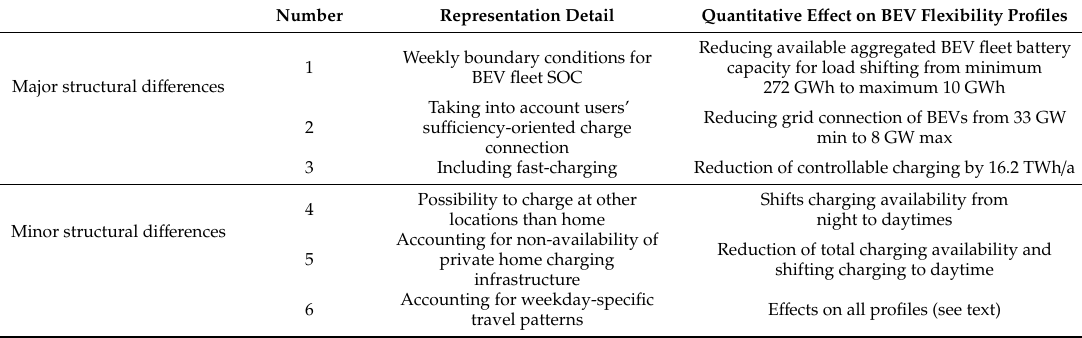
Table 7. Structural di ff erences in BEV charging representation between VencoPy and CURRENT. Shown are structural di ff erences in the models VencoPy and